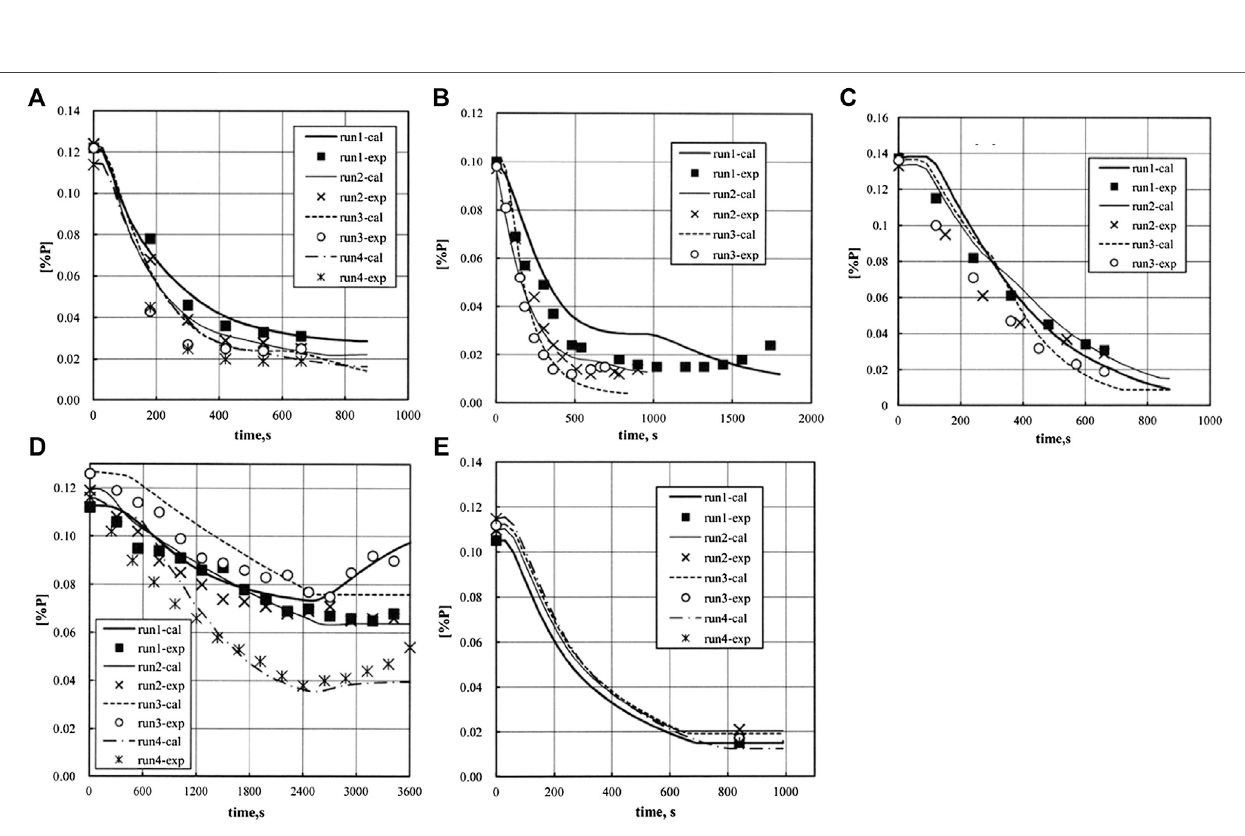
Frontiers in Materials |